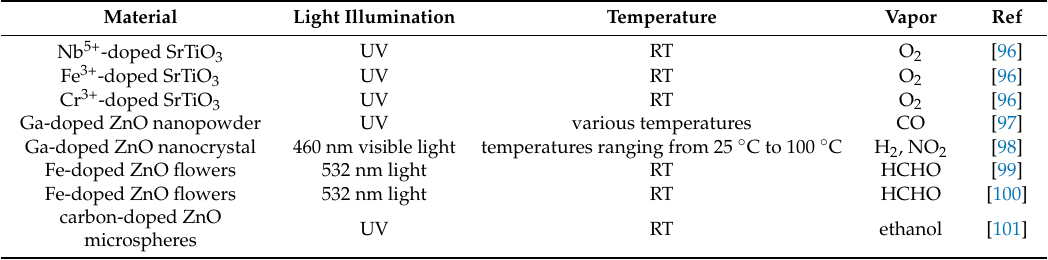
Table 5. Summary of typical advances on light-activated gas sensor based on metal oxides with